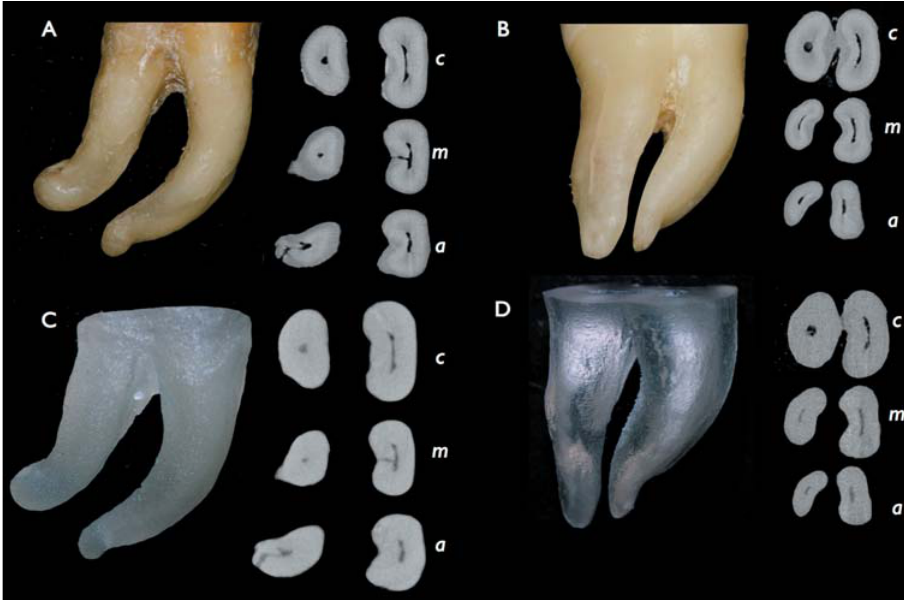
Figure 1- Mandibular molar specimens showing a continuous 62-degree curvature of the mesial root (A) and a S-shaped mesial root (B). Respective replicas are also presented (C - D). Microcomputed tomography transversal sections show (cid:68)(cid:3)(cid:57)(cid:72)(cid:85)(cid:87)(cid:88)(cid:70)(cid:70)(cid:76)(cid:3)(cid:55)(cid:92)(cid:83)(cid:72)(cid:3)(cid:44)(cid:3)(cid:70)(cid:82)(cid:81)(cid:191)(cid:74)(cid:88)(cid:85)(cid:68)(cid:87)(cid:76)(cid:82)(cid:81)(cid:3)(cid:76)(cid:81)(cid:3)(cid:69)(cid:82)(cid:87)(cid:75)(cid:3)(cid:80)(cid:72)(cid:86)(cid:76)(cid:68)(cid:79)(cid:3)(cid:85)(cid:82)(cid:82)(cid:87)(cid:86)(cid:3)(cid:90)(cid:76)(cid:87)(cid:75)(cid:3)(cid:68)(cid:3)(cid:85)(cid:76)(cid:69)(cid:69)(cid:82)(cid:81)(cid:16)(cid:86)(cid:75)(cid:68)(cid:83)(cid:72)(cid:71)(cid:3)(cid:70)(cid:68)(cid:81)(cid:68)(cid:79)(cid:3)(cid:73)(cid:85)(cid:82)(cid:80)(cid:3)(cid:87)(cid:75)(cid:72)(cid:3)(cid:70)(cid:72)(cid:85)(cid:89)(cid:76)(cid:70)(cid:68)(cid:79)(cid:3)(cid:87)(cid:82)(cid:3)(cid:87)(cid:75)(cid:72)(cid:3)(cid:68)(cid:83)(cid:76)(cid:70)(cid:68)(cid:79)(cid:3)(cid:87)(cid:75)(cid:76)(cid:85)(cid:71)(cid:17)(cid:3)(cid:36)(cid:3) decrease of the radiolucent area in the root canal space of molar replicas is related to the supporting material used during the printing process (wax). The reproduction of accessory anatomy as isthmuses and lateral canals can be observed in respective microcomputed tomography sections of molar